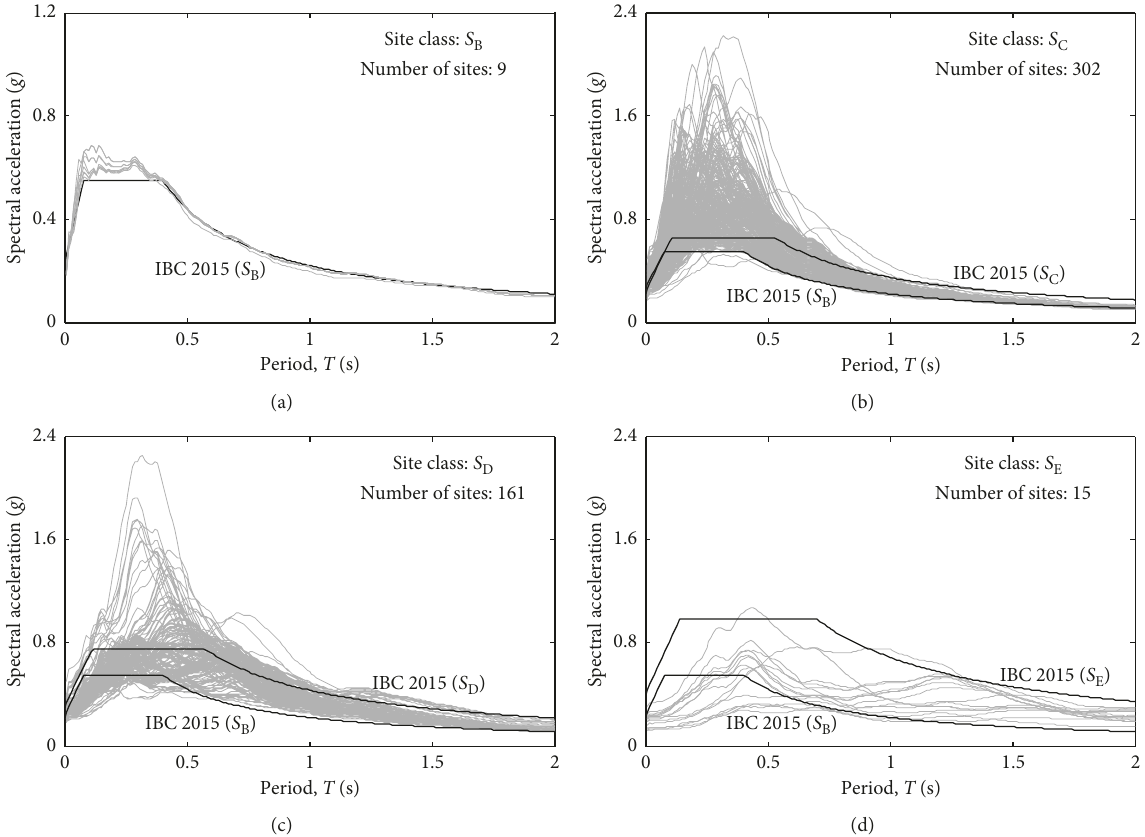
Figure 7: Response spectrum resulting from numerical analysis for 487 sites (reference effective peak ground acceleration (EPGA) � 0.22g) for (a) S B . (b) S C . (c) S D . (d) S E